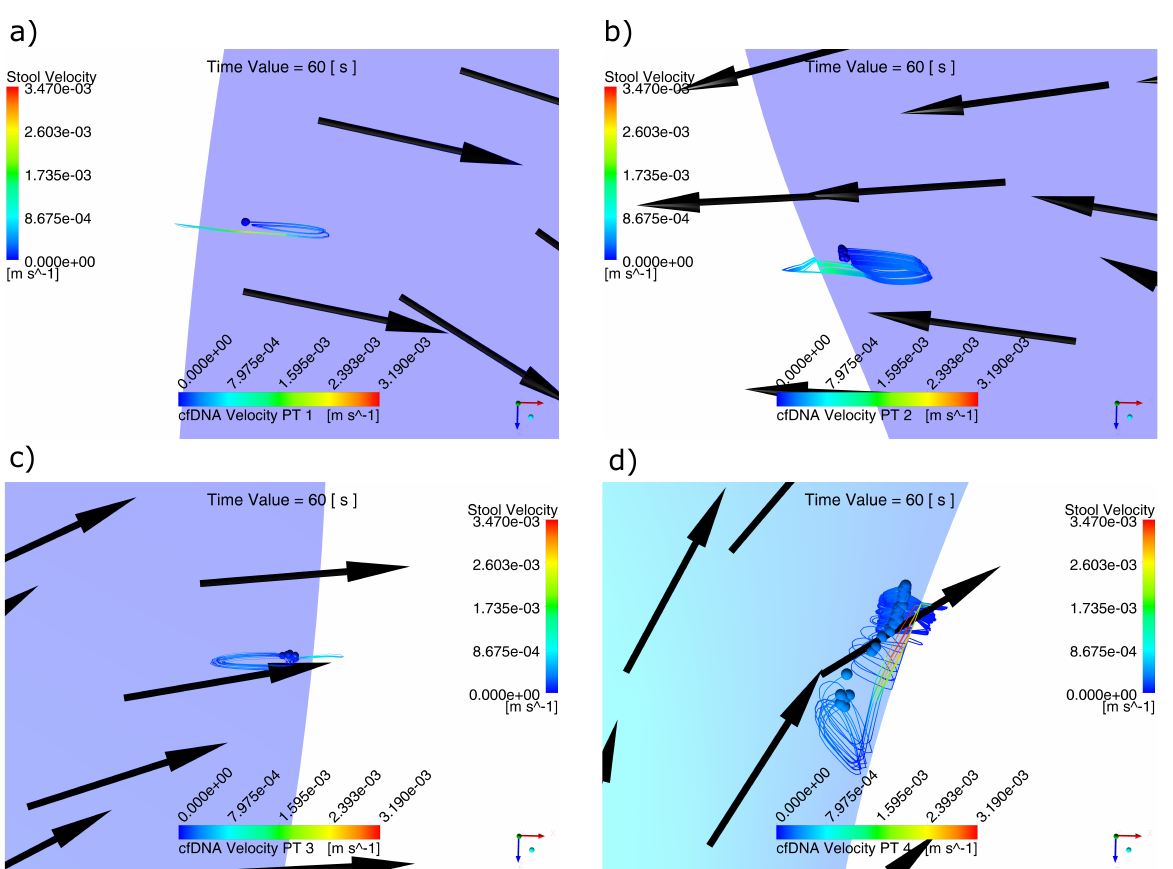
Figure 6. Behavior of the cfDNA particles for t = 60 s: ( a ) region PT1, ( b ) region PT 2, ( c ) region PT 3 and ( d ) region PT 4. The behavior of almost circular trajectories with an advance in the retrograde direction can be explained by the constant change in the direction and magnitude of the velocity field generated by the peristaltic wave.